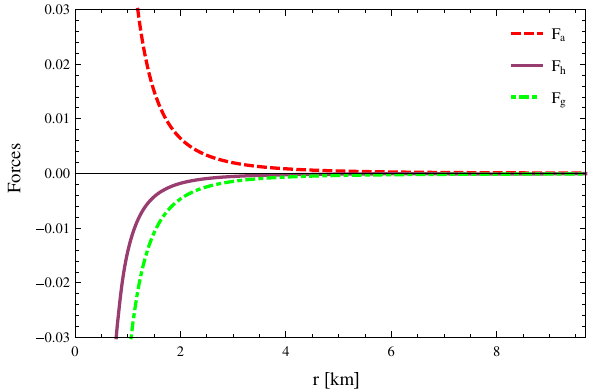
Fig. 8 Behaviour of the compactness function when α 1 = 0 . 45, α 2